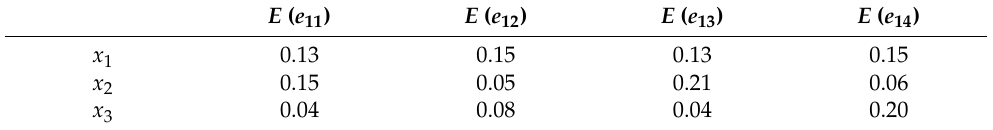
Table 1. Entropy of each parameter of hydrological and climatic conditions B 1 at time t 1 .